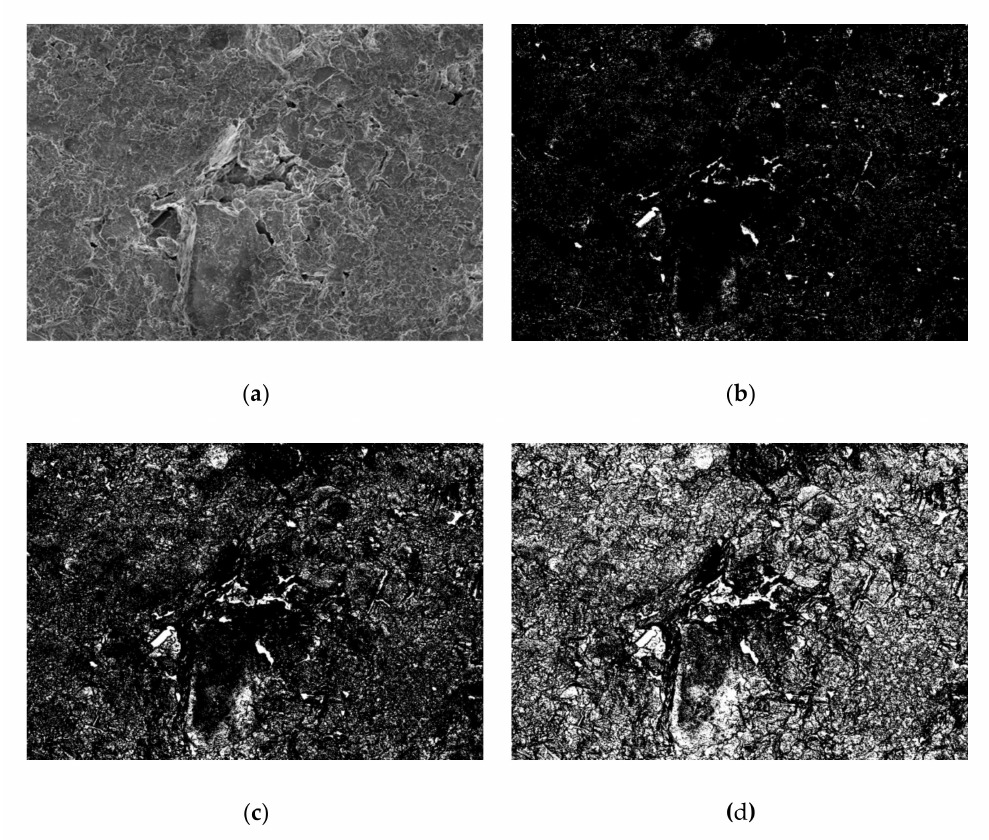
Figure 13. Analysis of SEM image by binarization method for the clay soil compacted under 106 MPa vertical pressure. ( a ) Original SEM image; ( b ) CAR = 98.39% (Gray value = 40); ( c ) CAR = 92.57% (Gray value = 60); ( d ) CAR = 79.56% (Gray value =